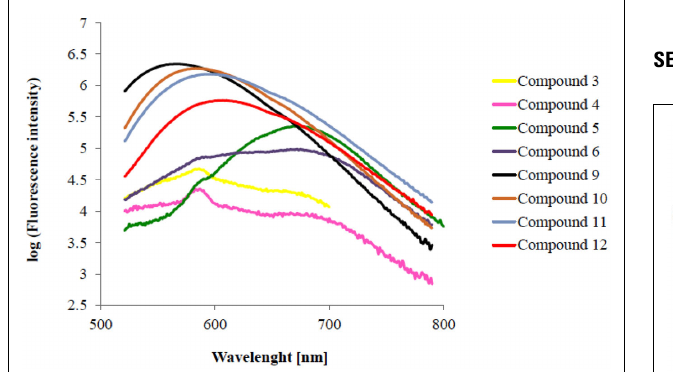
SELECTIVITY DATA